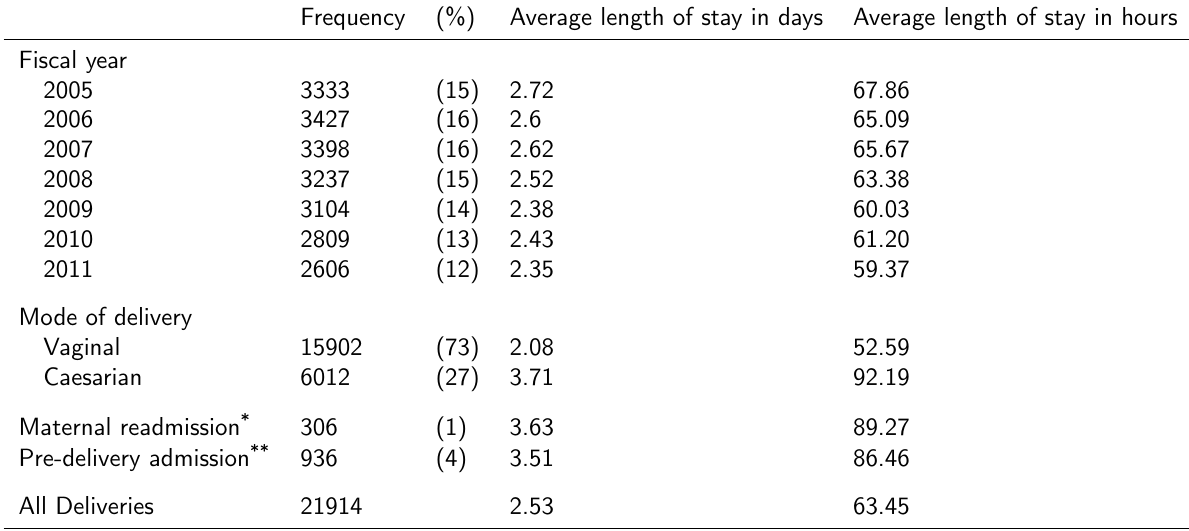
Table 2: Delivery characteristics for 21,914 deliveries